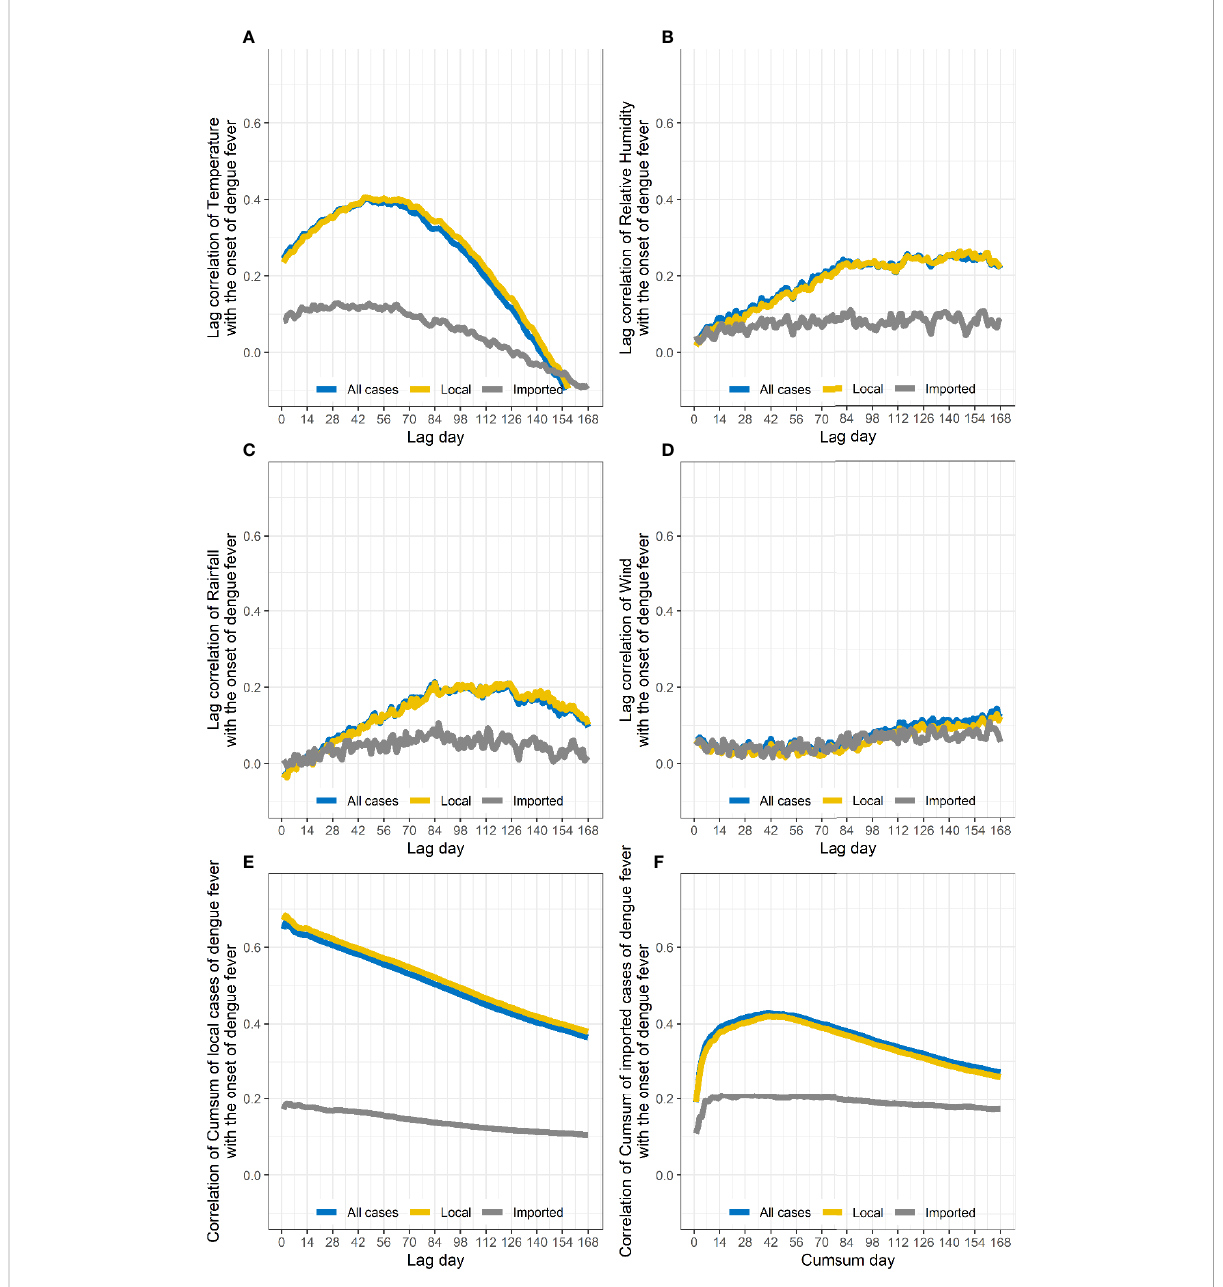
FIGURE 5 Changes in correlation coef fi cients between the number of people with dengue on different lag days and meteorological factor. The number of local cases is related to the daily average temperature (A) , relative humidity (B) , accumulated precipitation (C) , and average daily wind speed lagging 1 – 168 days (D) as well as the cumulative number of local cases in the previous 1 – 168 days (E) and the cumulative number of input cases in the previous 1 – 168 days (F)